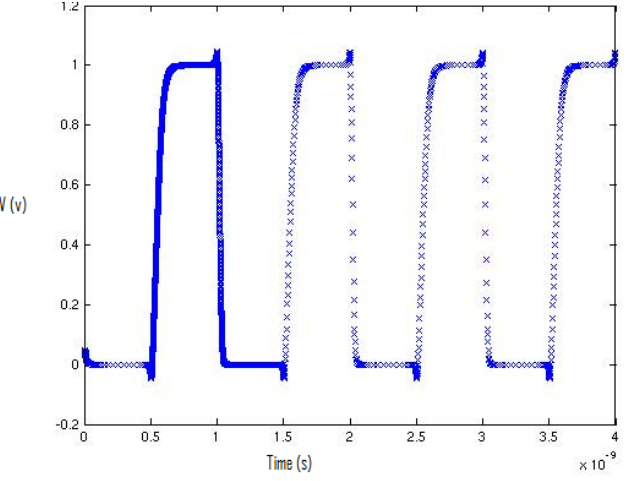
Figure 4. Output plot of the inverter in MATLAB: the first cycle of the waveform contains 5000 equidistant data points.